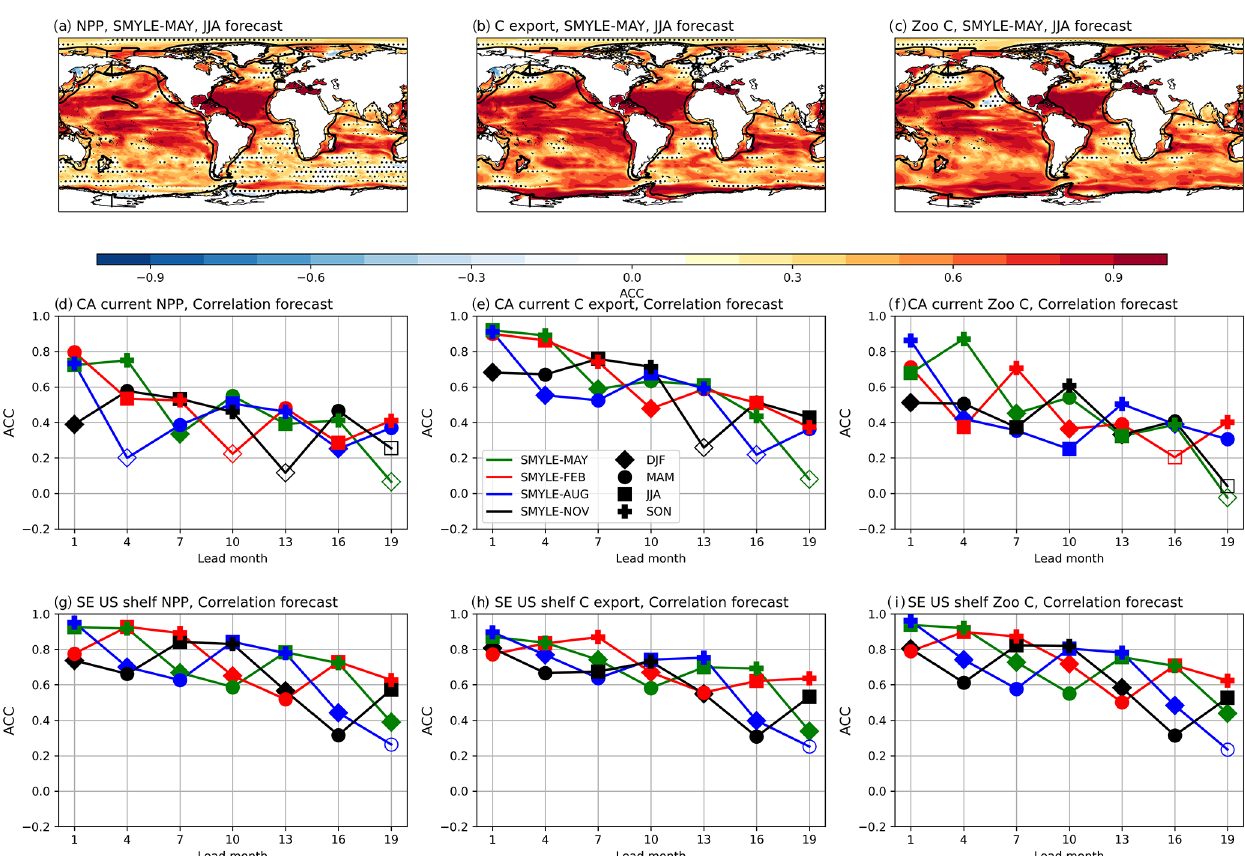
Figure 8. Anomaly correlation coefficients for SMYLE-MAY lead month 1 (JJA target season) forecasts of (a) net primary productivity, (b) carbon export, and (c) zooplankton carbon. ACC skill for spatially averaged seasonal fields as a function of lead month for (d–f) the California Current System and (g–i) the southeastern US shelf regions. Large marine ecosystem (LME) boundaries are shown by black lines. Filled symbols in panels (d) – (i) indicate significant ACC scores ( p < 0.1).